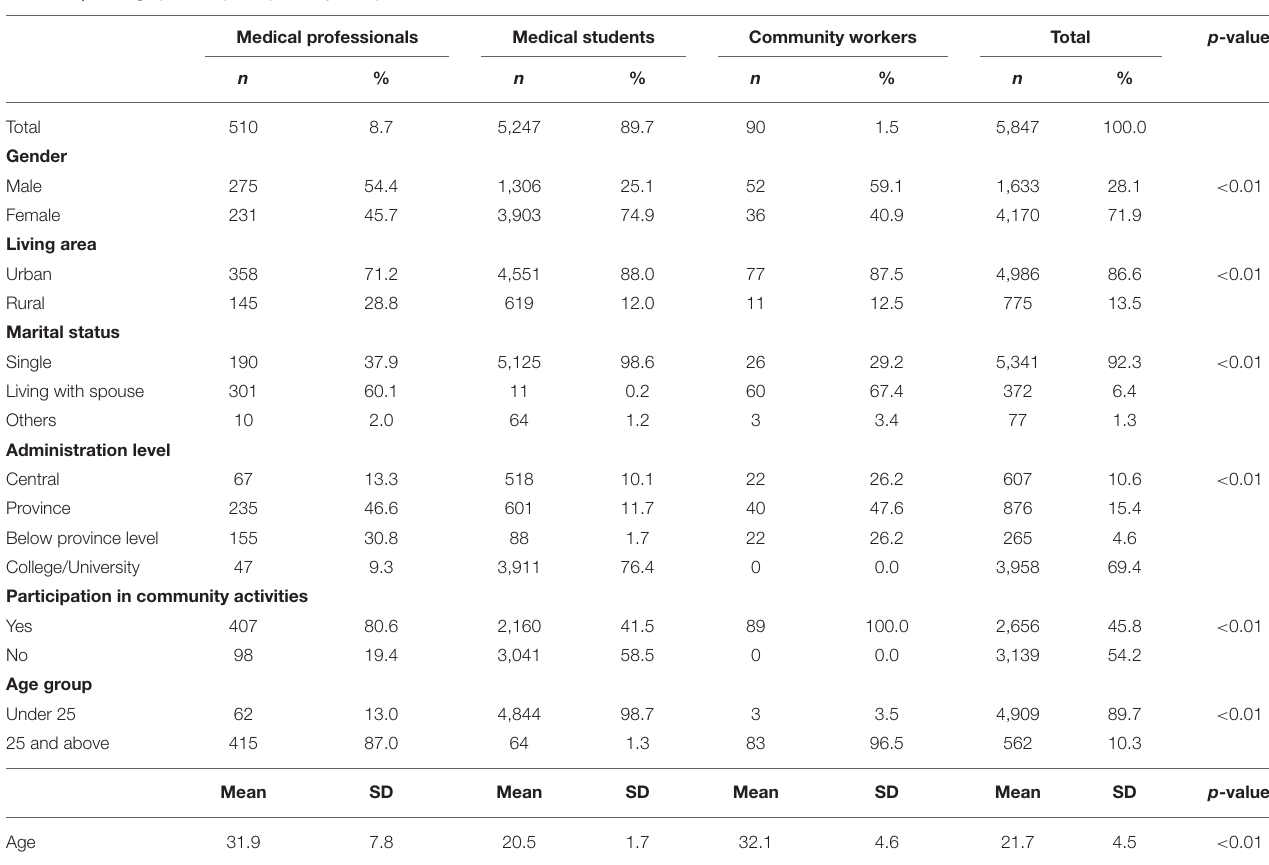
TABLE 1 | Demographics of participants by occupation. Medical professionals Medical